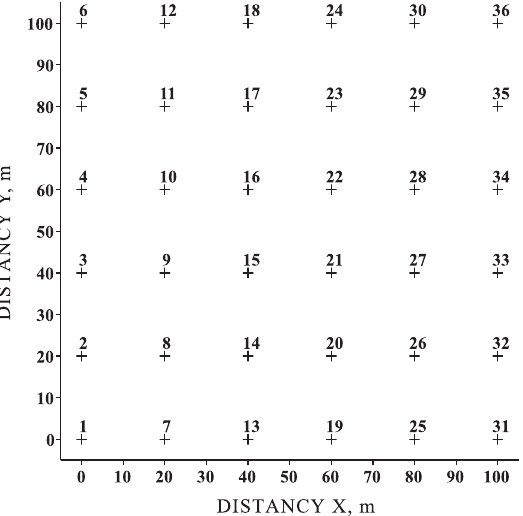
Figure 1. Sampling grid of the experimental